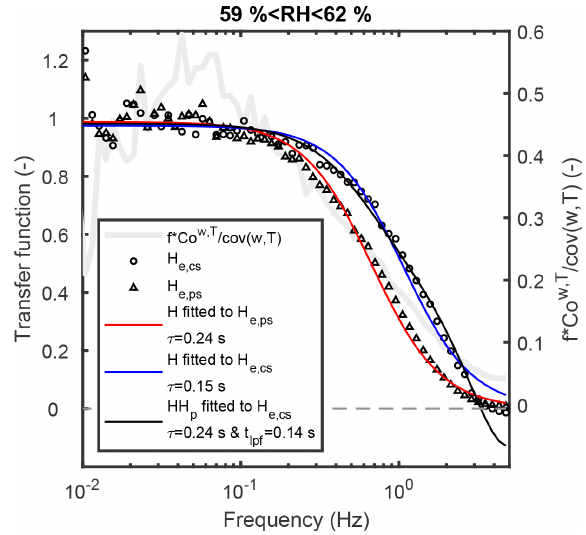
Figure 8. Similar figure as Fig. 7 but for H 2 O in moderate rel- ative humidity conditions (59% < RH < 62%). Note that τ esti- mated from H e , ps agrees with τ estimated from H e , cs with HH p . Data from Siikaneva were